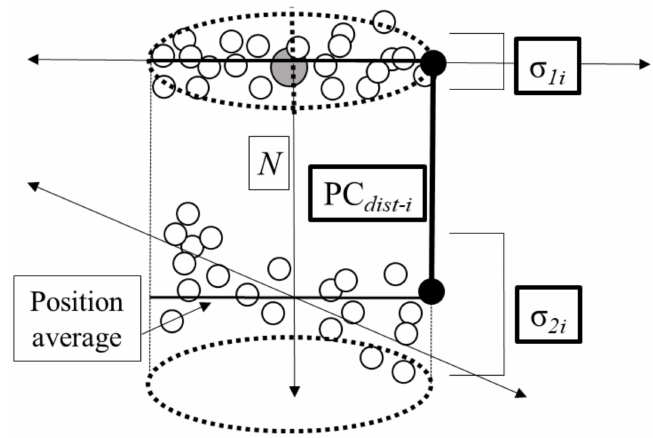
Figure 10. Normal ( N ) orientation and surface roughness between two compared point clouds. Misalignment between the surface orientations of the reference (top) and compared (bottom) point clouds is represented by thin arrows. This misalignment is captured by the large surface roughness of the compared cloud ( σ 2 i ) and will increase the uncertainty ( u i ) of the calculated distance between the two point clouds (PC dist-i ). The reference cloud’s surface roughness is represented by σ 1 i . The open circles represent cloud points. The grey circle represents a core point. The black circles denote the end of the thicker line representing PC dist-i